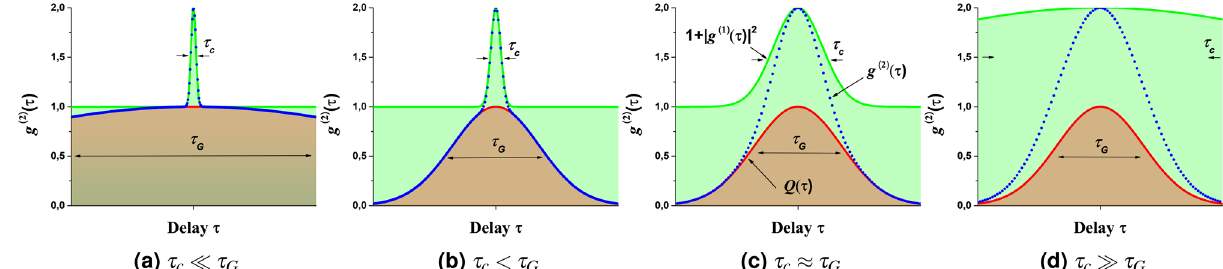
2 ) (τ) (blue dots) of a pulsed ASE source and its decomposition 1 ) (τ) | 2 (green curve)